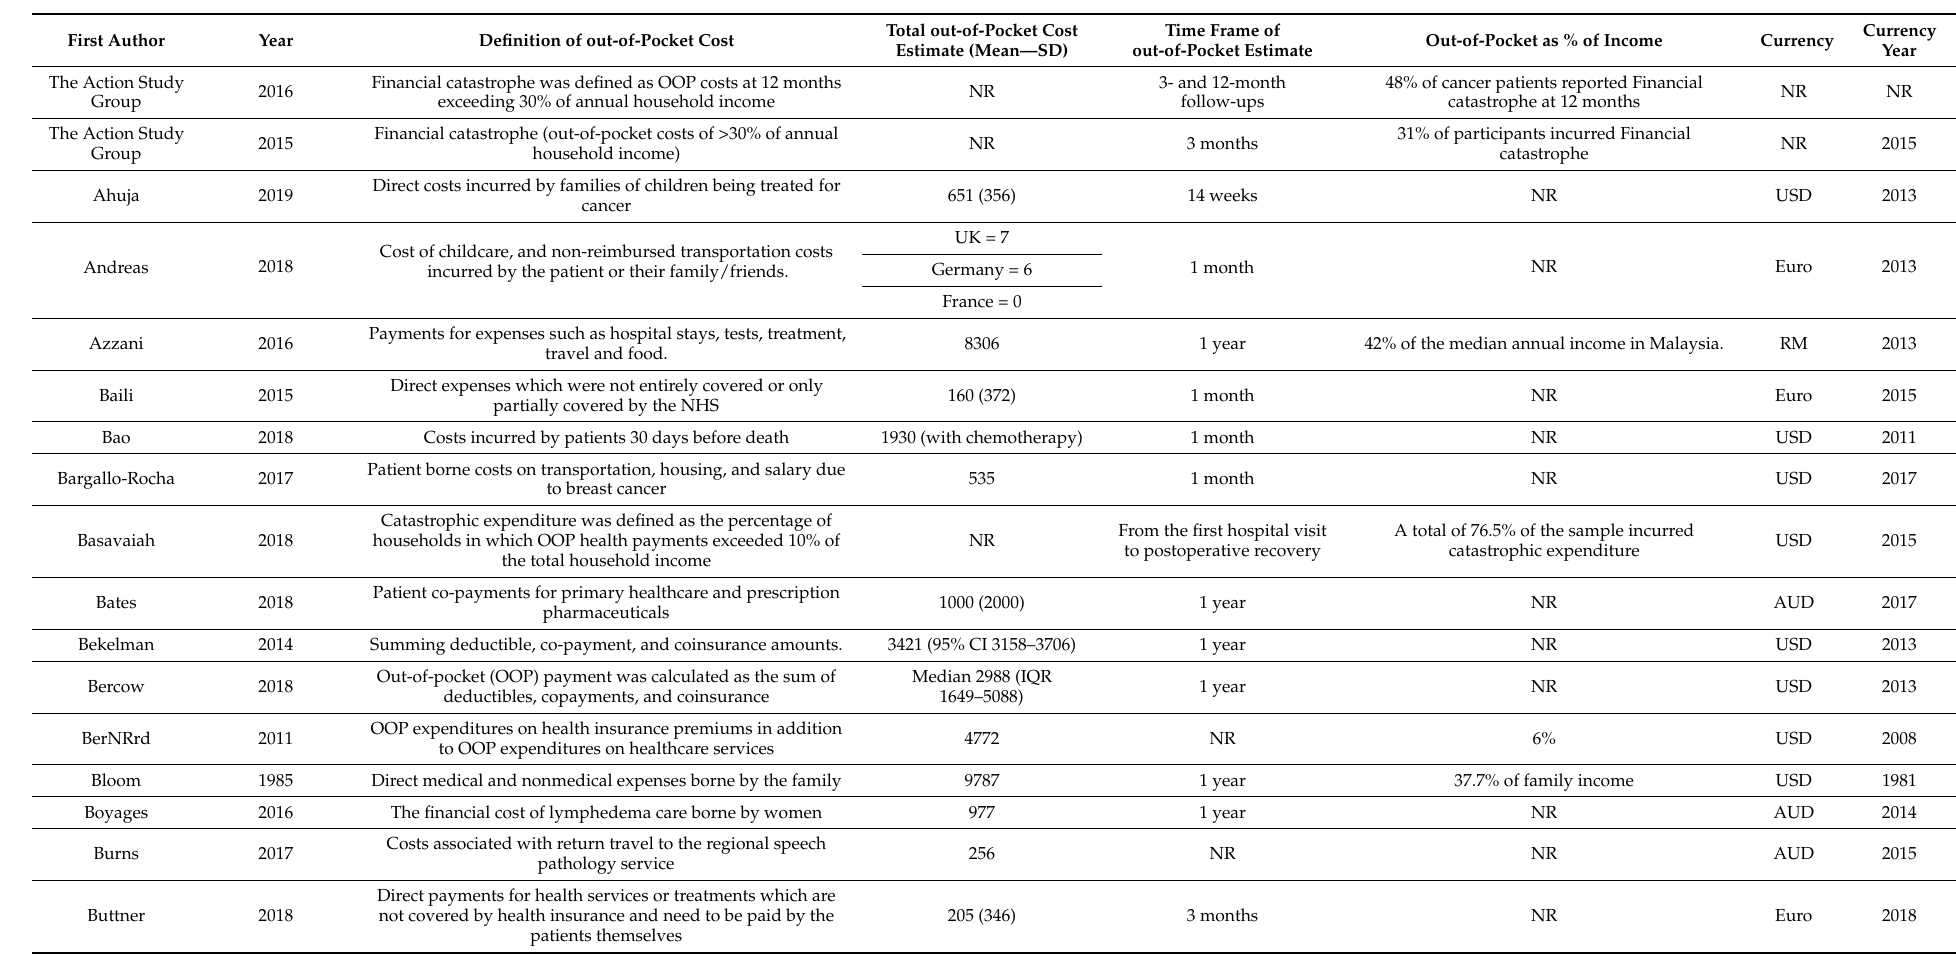
Table 2. Out-of-pocket